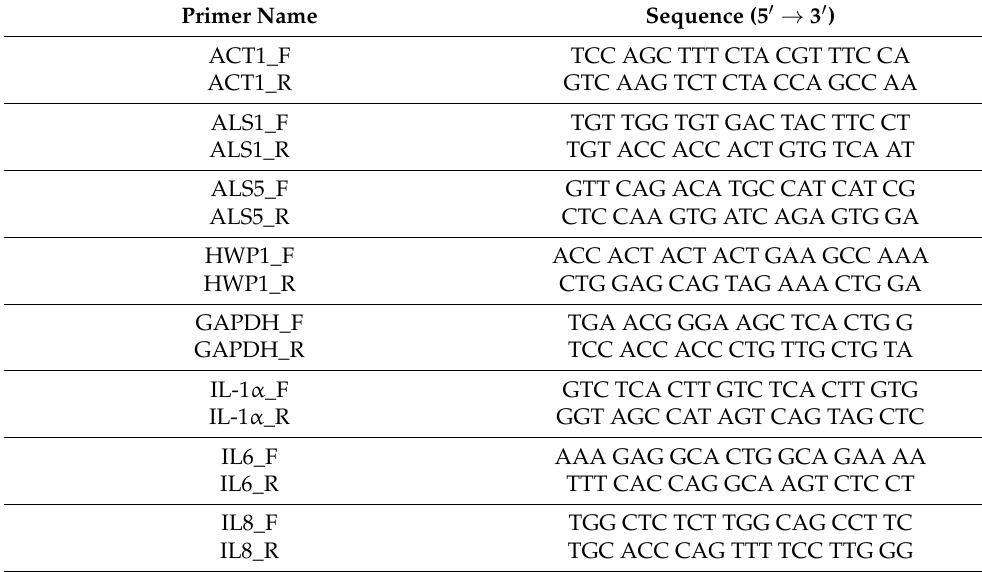
Table 3. Sequences of primers used for RT-qPCR in this